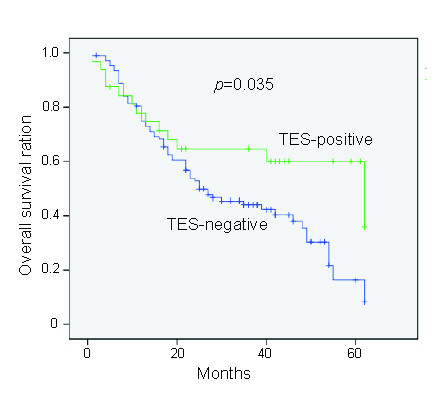
Estimated overall survival according to the expression of TES in 140 cases of primary GC (Kaplan-Meier method). The expression of TES was classified as negative expression (n = 108) and positive (n = 32) based on the immunohistochemical staining results.